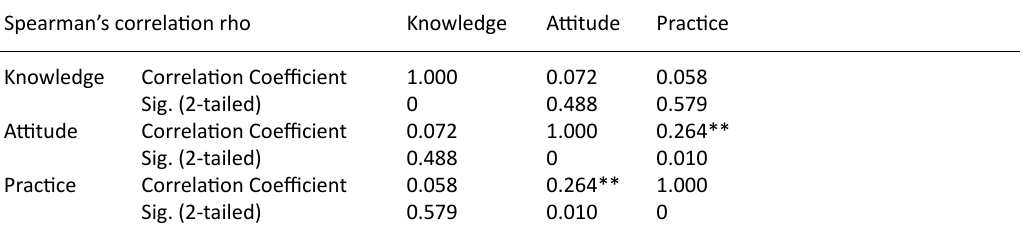
Table 6. Correlation between knowledge, attitude and practice on prevention of CAUTI among healthcare professionals (n-95) Spearman’s correlation rho Knowledge